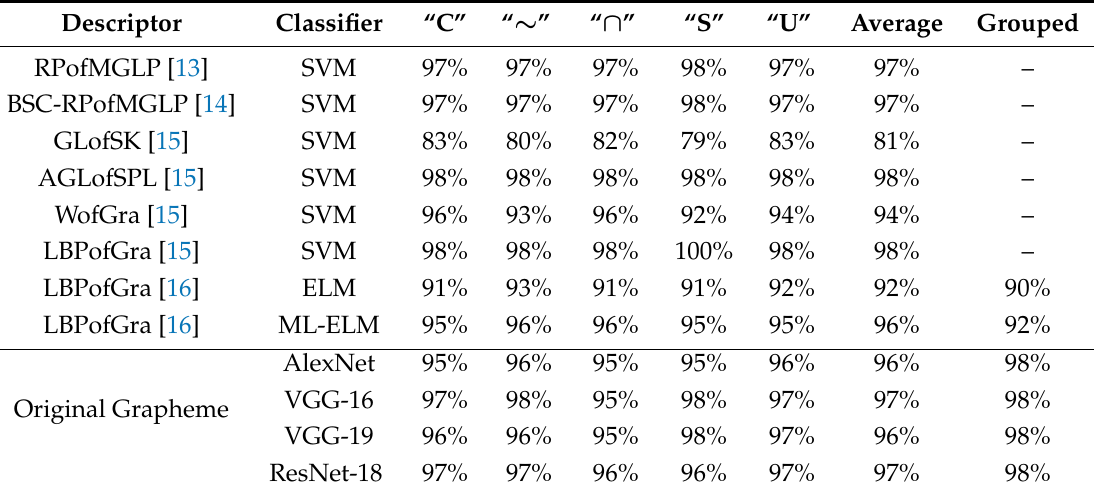
Table 12. Comparison respect to other